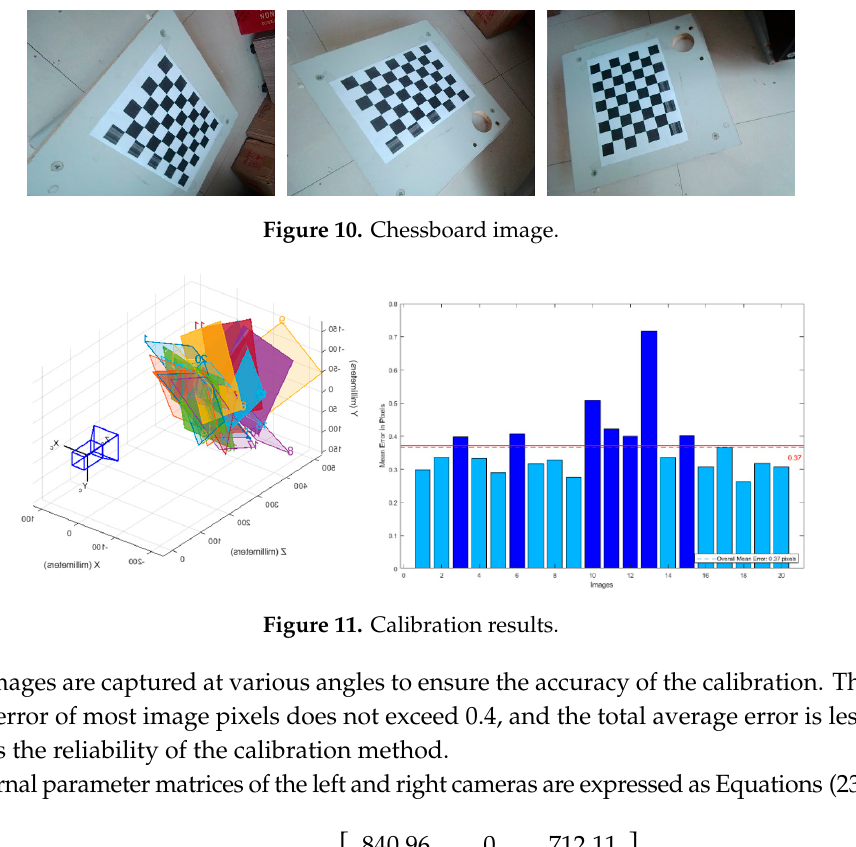
Figure 10. Chessboard image.